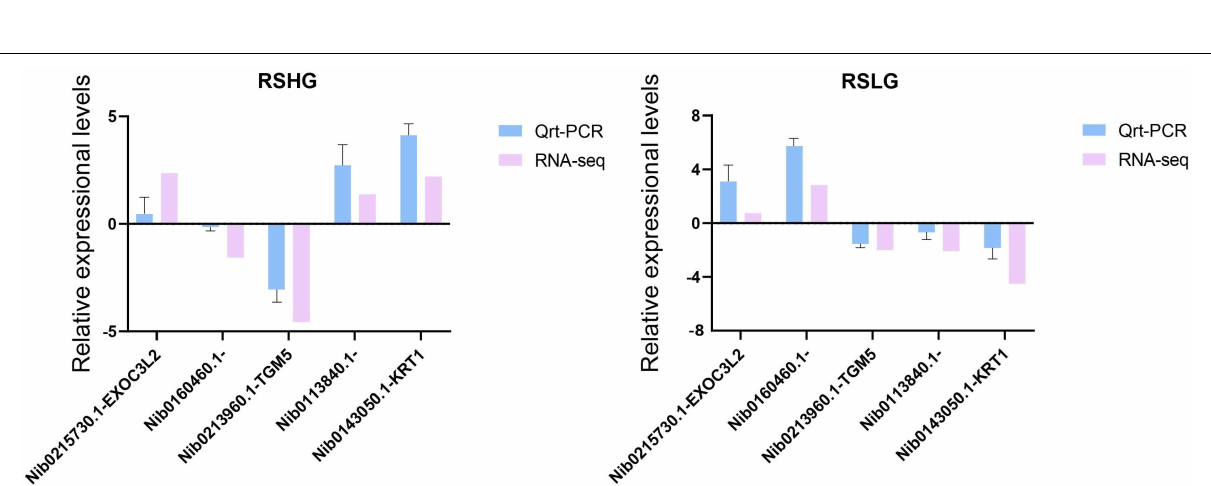
Frontiers in Marine Science |